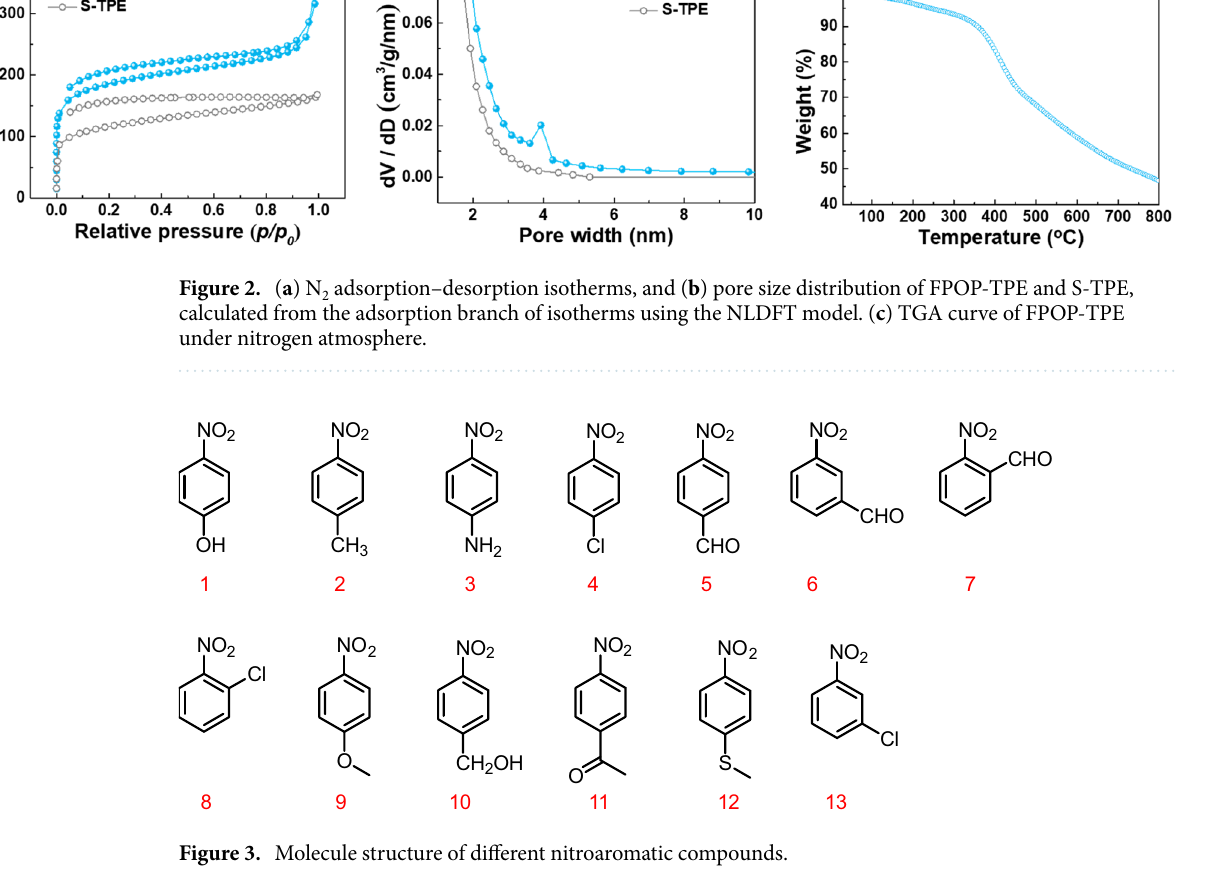
Figure 3. Molecule structure of different nitroaromatic